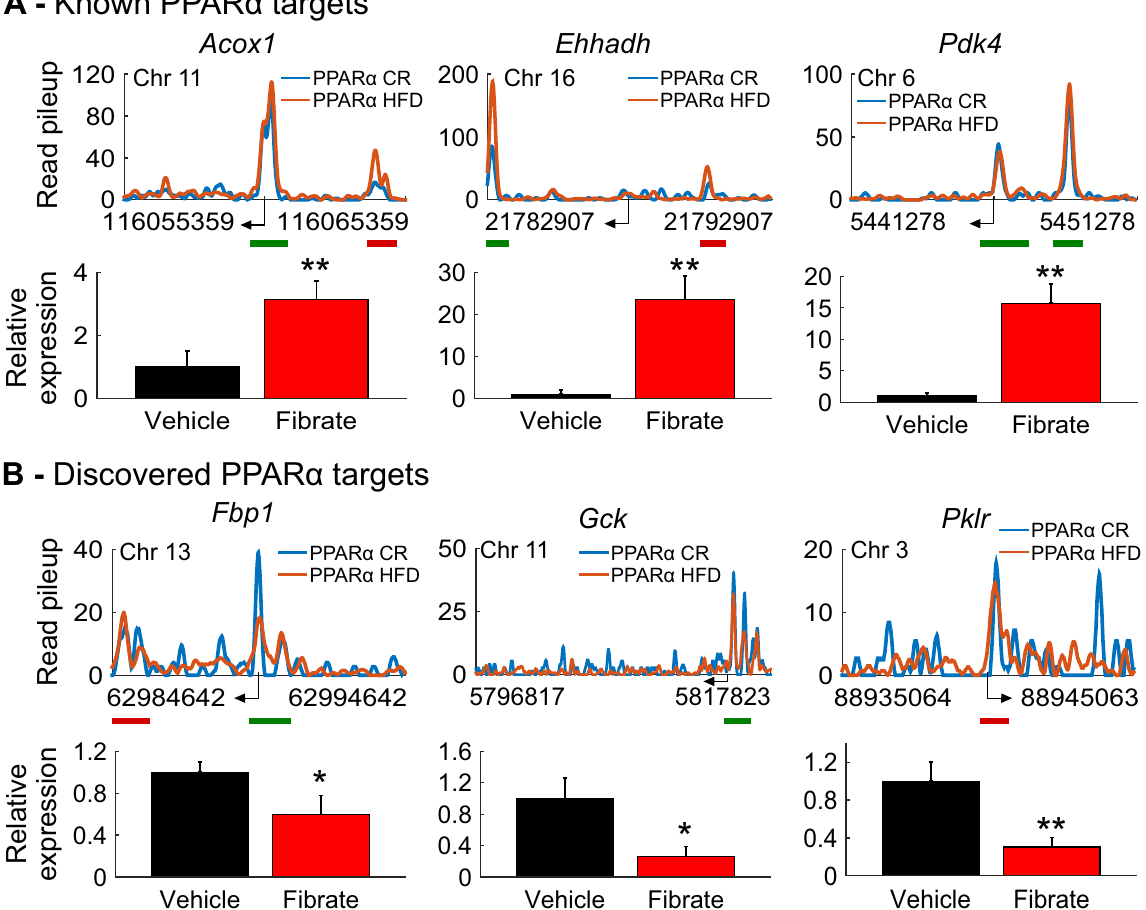
Figure 5. Identified targets are regulated in vivo by PPAR α . ( A ) Read pileup profiles for CR and HFD PPAR α ChIP-Seq near known regulated genes with corresponding in vivo qPCR results following fenofibrate treatment. ( B ) Read pileup profiles for CR and HFD PPAR α ChIP-Seq near novel regulated genes with corresponding in vivo qPCR results following fenofibrate treatment. Read pileup refers to extended, normalized, and smoothed read pileup counts extracted from concatenated pools of aligned reads for the biological replicates for each factor (see Methods). Green lines indicate significantly called peaks in both CR and HFD. Red and blue lines indicate significantly called peaks in HFD and CR, respectively. * p < 0.05, ** p <